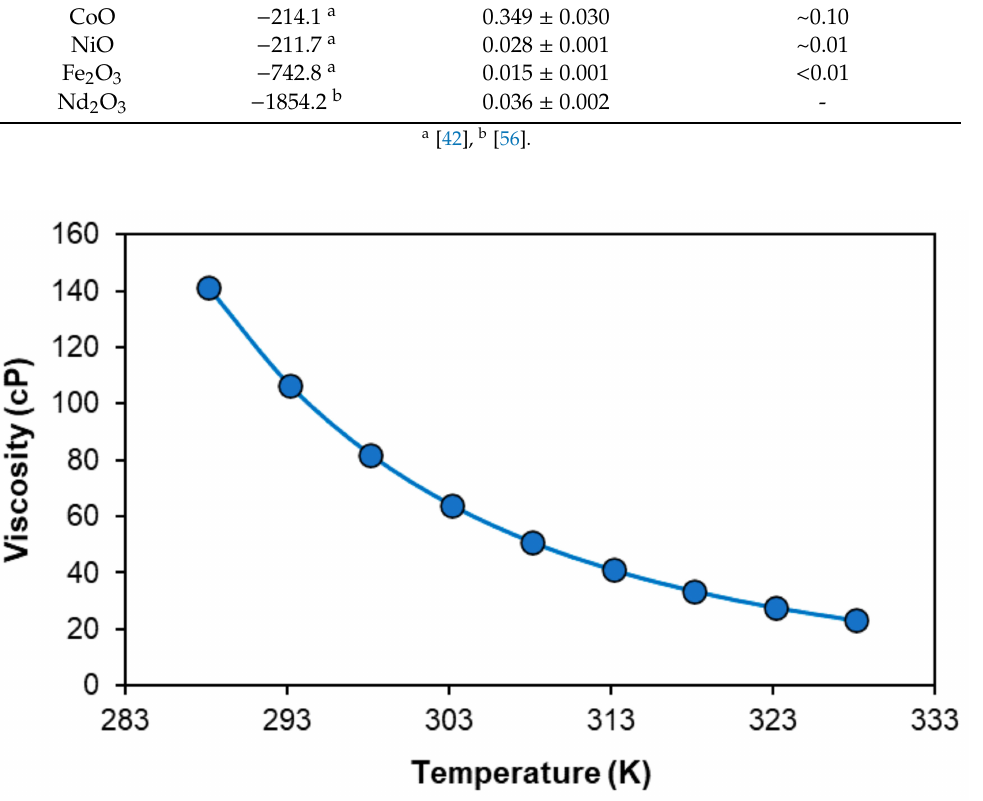
Figure 4. Viscosity of the 73.0 wt.% [P 44414 ]Cl and 27.0 wt.% CH 3 COOH mixture as a function of